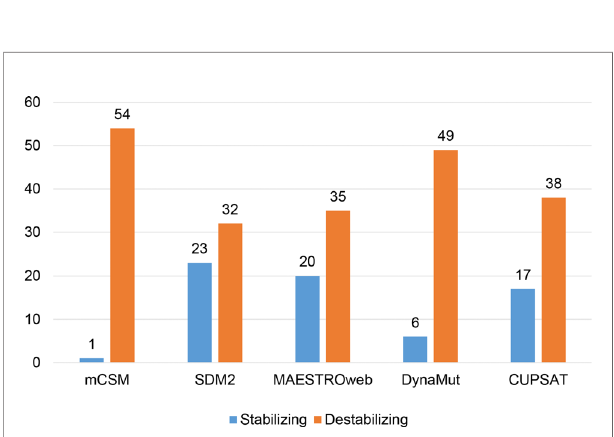
FIGURE 3 | Distribution of stabilizing and destabilizing mutations in SARS- CoV-2 Main Protease predicted by structure-based tools.